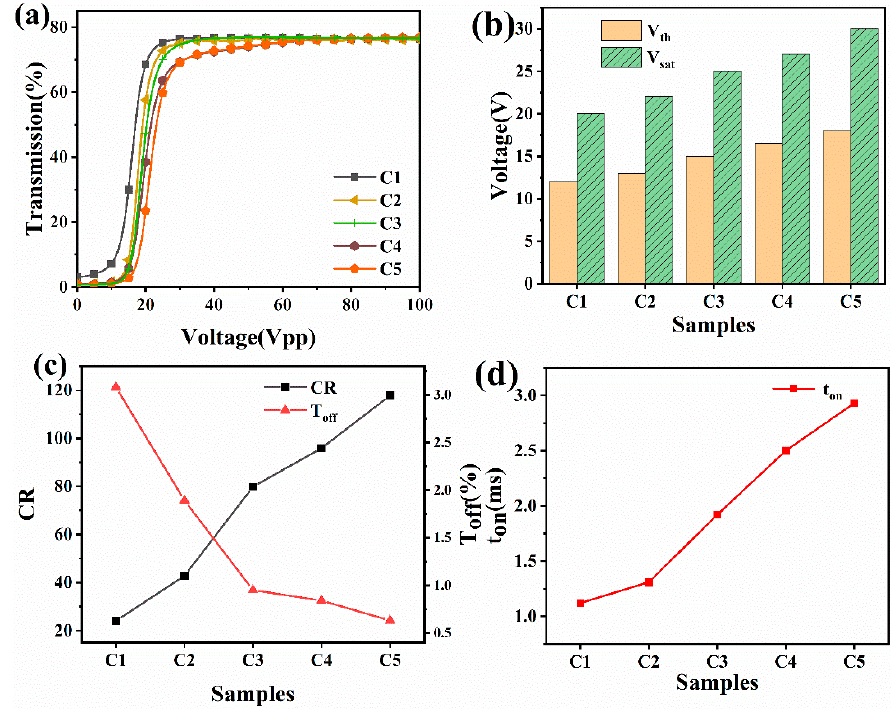
Figure 8. ( a ) Transmittance of specimens C1–C5 is dependent on the applied electric field (100 Hz); ( b ) Contrast ratio and off-state transmittance of specimens C1–C5; ( c ) Threshold voltage and satura- tion voltage of specimens C1–C5; ( d ) Reaction times of specimens C1–C5.